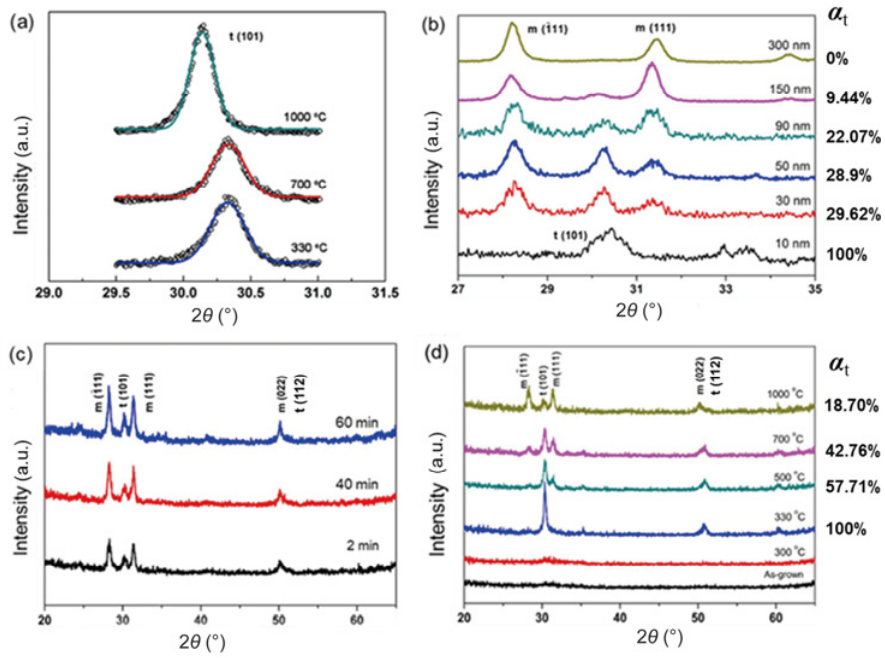
Fig. 4 (a) Fitting of t(101) diffraction peaks for 90-nm-thick ZrO 2 thin film measured at different temperatures. (b) Residual phase proportions in 10–300-nm-thick ZrO 2 thin film after cooling to RT. (c) XRD results of 90-nm-thick ZrO 2 thin film annealed for different durations. (d) XRD results of 90-nm-thick ZrO 2 thin film annealed at different temperatures. Note: α t is the fraction of